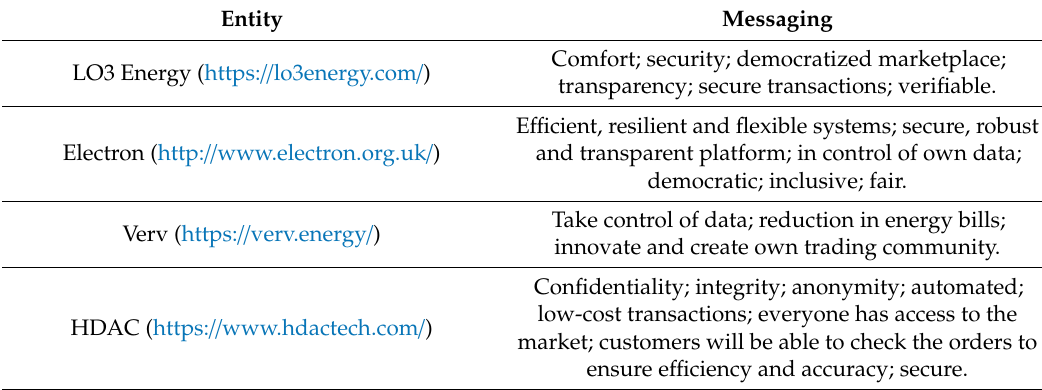
Table A1. Summary of company